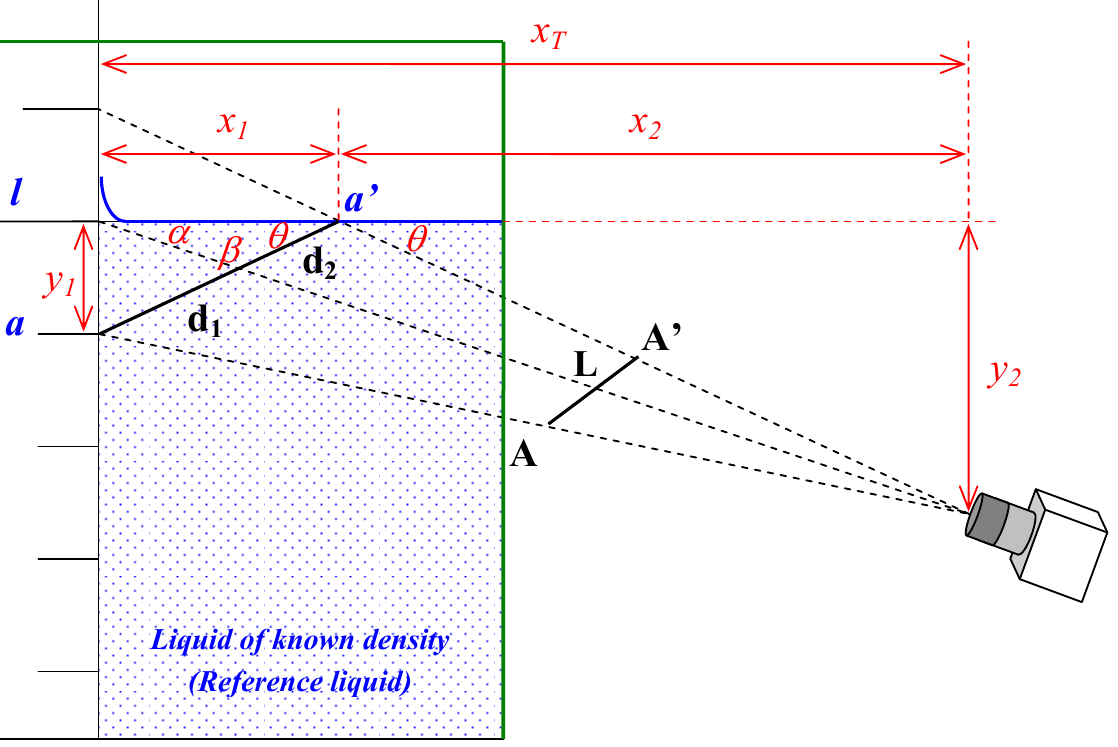
Figure 3. Scheme based on the pin-hole camera model approach to obtain the relation between d and d ( K 1 2